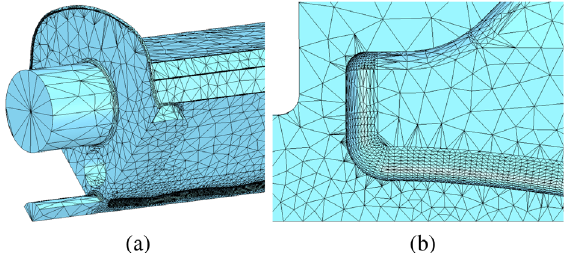
FIG. 3. Finite element mesh generated by HFSS at the output end (a) and close-up of the fine mesh used to represent the 3D- curved vane tips (b).